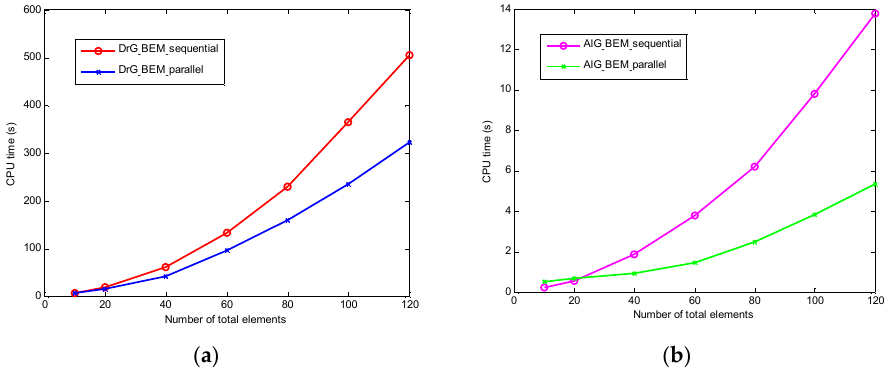
Figure 9. CPU time of the two boundary element methods based on different calculation schemes of the free-surface Green function in sequential or parallel mode: ( a ) comparison for the direct integration method; and ( b ) comparison for the analytical solution method.